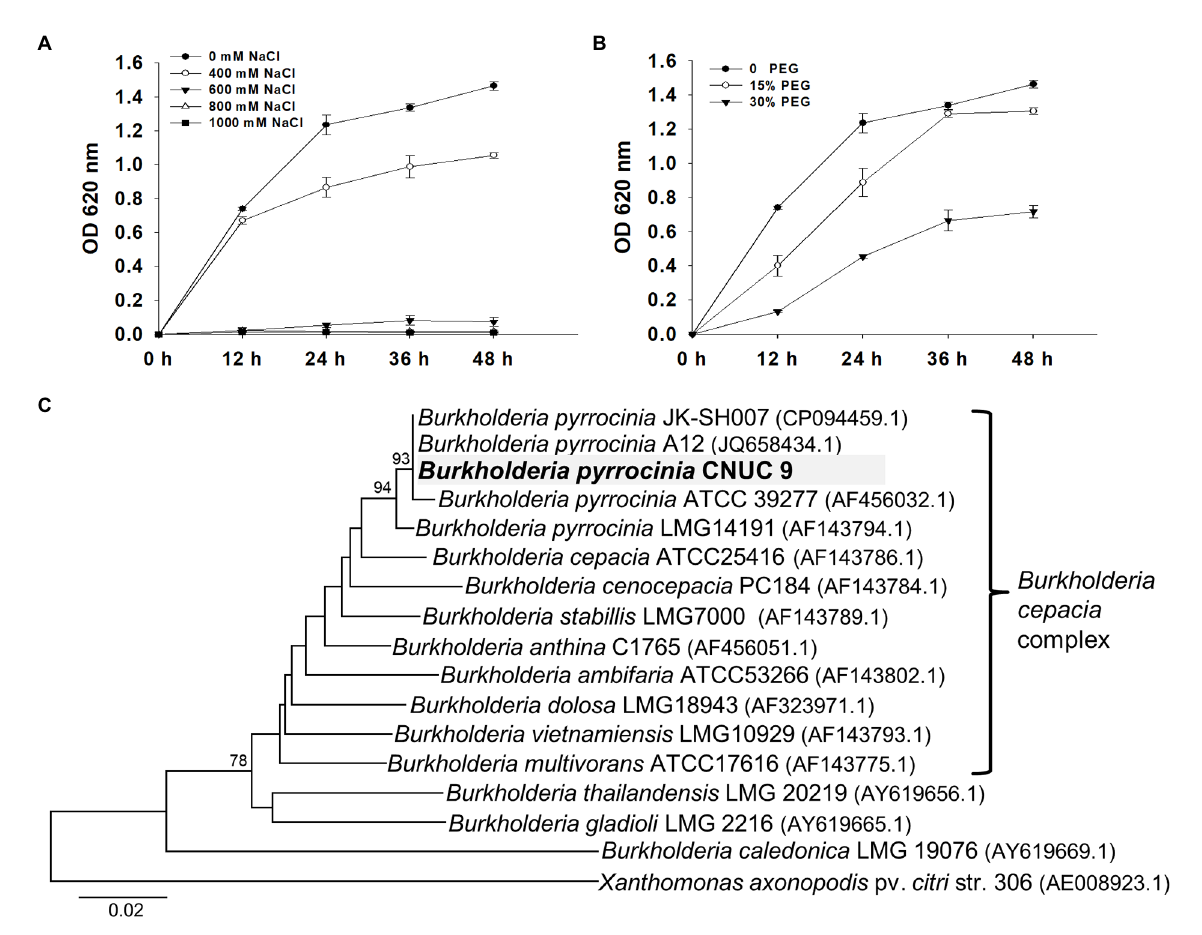
FIGURE 1 Growth curve and phylogenetic analysis of B. pyrrocinia CNUC9. Data for B. pyrrocinia CNUC9 growth curves were measured in liquid LB medium supplemented with (A) different NaCl concentrations (0, 400, 600, 800, or 1,000 mM), or (B) PEG 6000 concentrations (0, 15%, or 30%) incubated at 28 ° C for 48 h with rapid agitation. Error bars represent standard error (SE, n = 9). (C) Maximum likelihood tree inferred from analysis of recA gene sequences of Burkholderia species. Bootstrap values ≥ 70% based on 1,000 replicates are shown at the nodes. Xanthomonas axonopodis pv. citri str. 306 was used as an outgroup. Evolutionary distances were computed using the Kimura 2-parameter method and were expressed in numbers of base substitutions per site. Evolutionary analyses were conducted using the MEGA v6